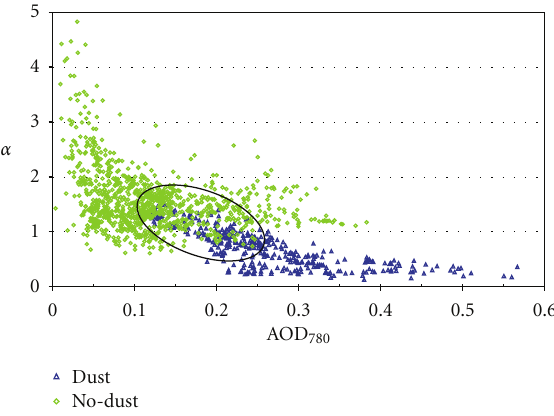
Figure 3: Scatter-plot alpha parameter versus AOD 780 : blue tri- angles represent dust data, and green rhombus represent no-dust data. Black ellipse contains dust data overlapping no-dust data, corresponding to mixed